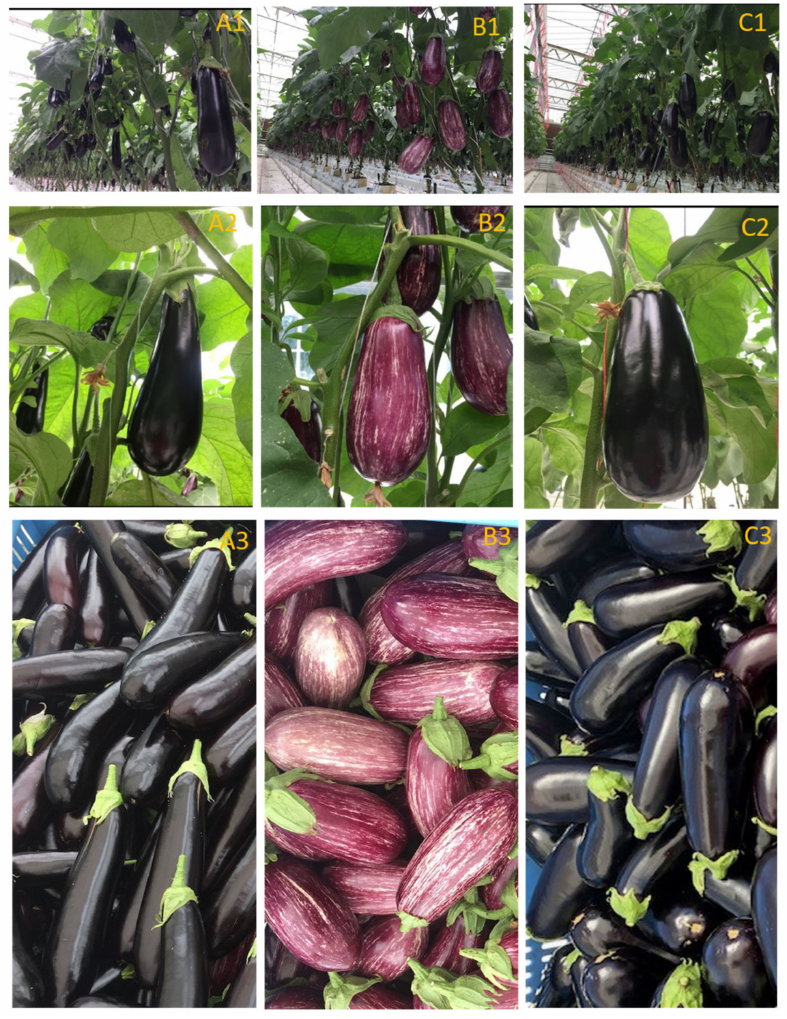
Figure 4. Eggplant grown in the high-tech greenhouse: Longa ( A1 – A3 ); Lydia ( B1 – B3 ); Tracey ( C1 – C3